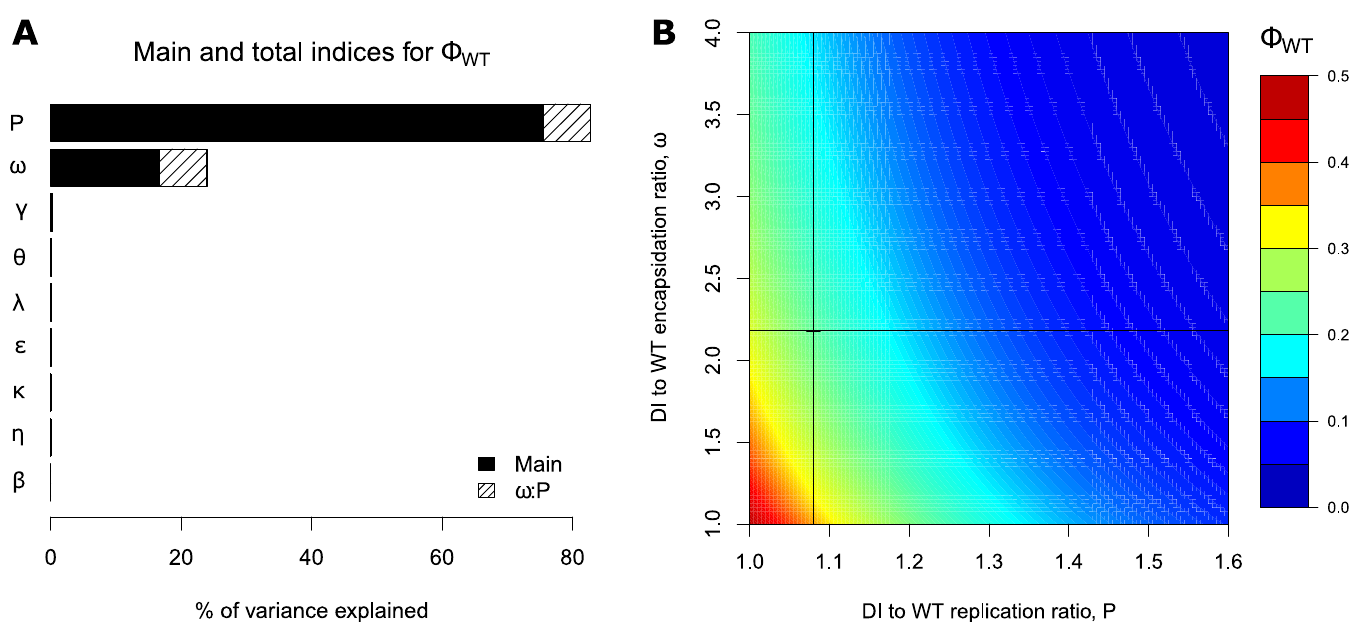
Fig 4. Sensitivity indices for the proportion of WT virions at cell lysis ( F WT ) and the impact of the most important parameters. A: Main, total and most important interaction indices for F . Main indices correspond to single parameter effect (black parts), and total indices add the effect of the factor in interaction with all other WT factors (second-order interactions, full bars). Hatched areas represent the importance of the strongest pairwise interaction between defective interfering (DI) to WT encapsidation ratio ω and DI to WT replication ratio P . B: Heat map representing the impact of P and ω on F value. The cross and lines in (B) show estimated parameter values from fitting the model to the experimental data.